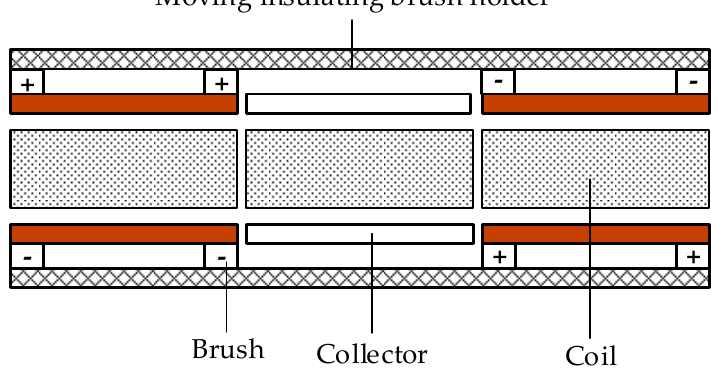
Figure 4. Energizing of coils with brush-collector system (with 8 brushes).